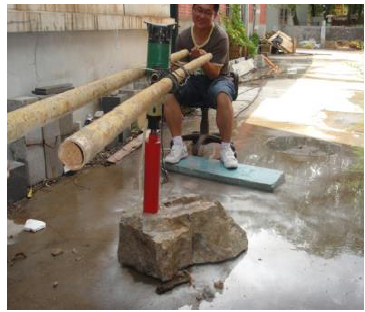
Figure 7. Drilling anchor hole.